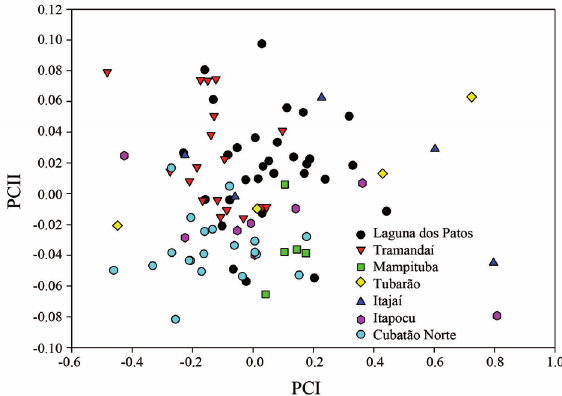
Fig. 14. Projection of individual scores in the space of first and second Principal Component axis for the populations of males of Astyanax laticeps . 62.0-83.0 mm SL), tributary of rio Jacuí at Nova Boêmia, Agudo. MCP 27772, 2, 60.7-69.6 mm SL, lajeado do Gringo at Linha das Pedras, Ibarama. MCP 28118, 1, 69.3 mm SL, arroio Amoras, Viamão. MCP 28954, 2, 53.0-60.7 mm SL, arroio Tolloti, tributary of